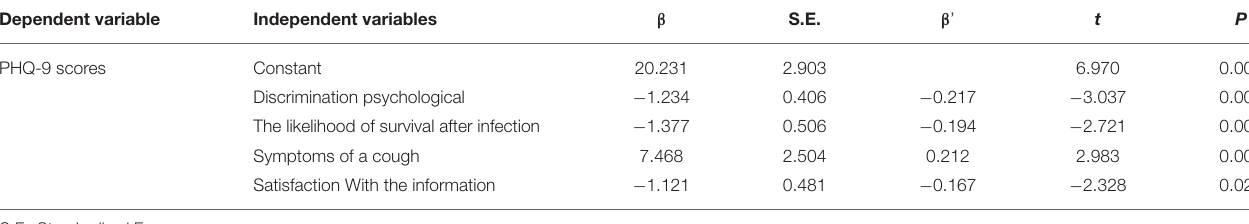
TABLE 5 | Stepwise regression analysis of the factors of depression due to COVID-19 among Chinese international students in South Korea. Dependent variable